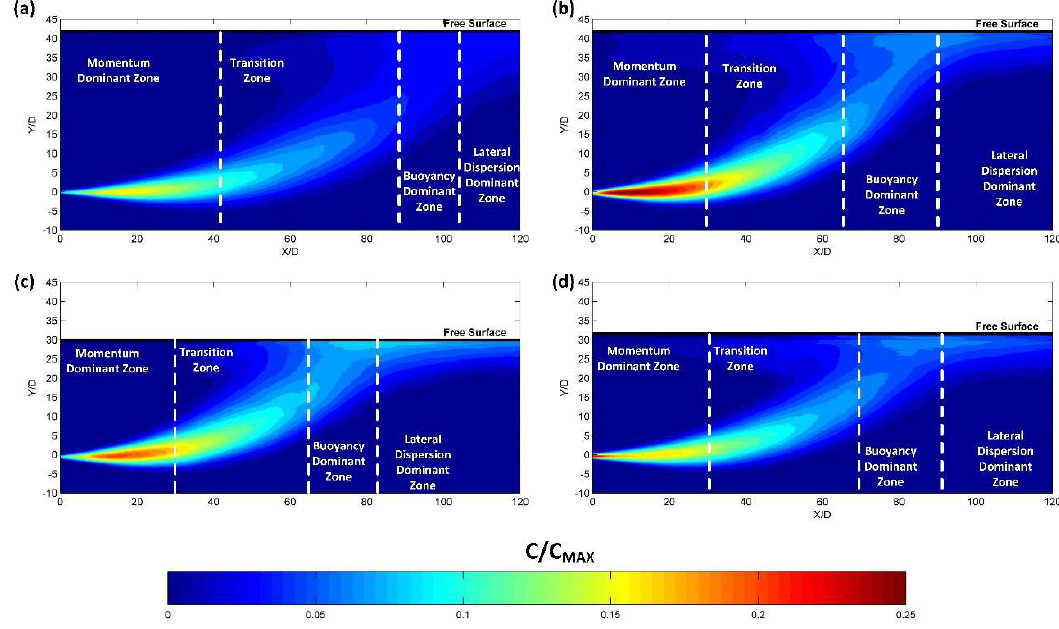
Figure 5. Dimensionless time-averaged concentrations (C / C MAX ) in a longitudinal view of the positively buoyant jet advance at the nozzle XY plane for the physical tests V1 ( a ), V2 ( b ), V3 ( c ), and V4 ( d ).